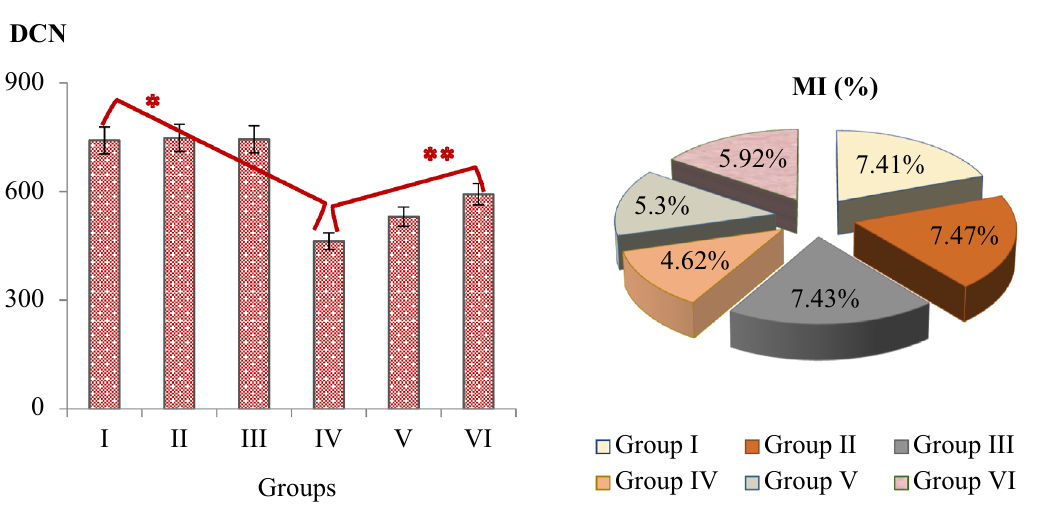
Figure 4. The effects of uranyl acetate and sage on DCN and MI (%). Group I: Control, Group II: 190 mg/L sage, Group III: 380 mg/L sage, Group IV: 0.1 mg/mL uranyl acetate, Group V: 0.1 mg/mL uranyl acetate + 190 mg/L sage, Group VI: 0.1 mg/mL uranyl acetate + 380 mg/L sage. MI was calculated by counting 10,000 cells in each group. *indicates statistical difference between Groups I and IV, **indicates statistical difference between Groups IV and VI ( p < 0.05). DCN: dividing cell number, MI: mitotic index.